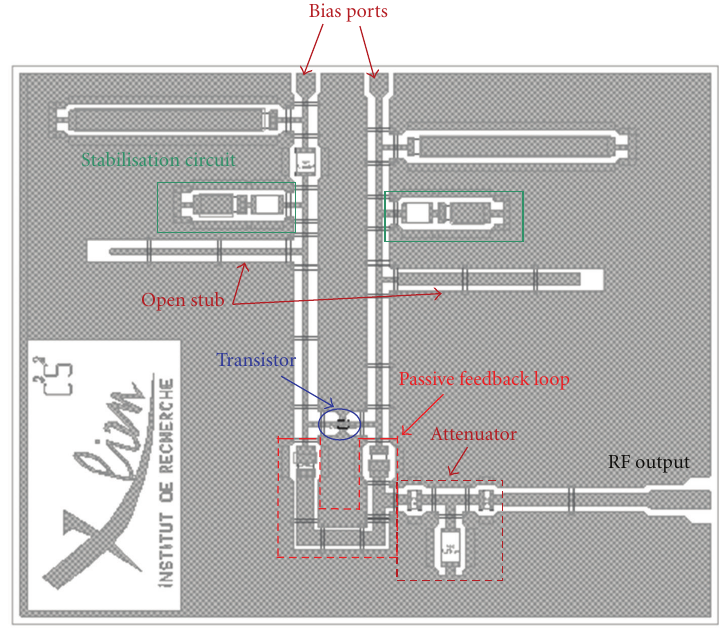
Figure 21: Oscillator layout (2070 × 1635 μ m 2 ).